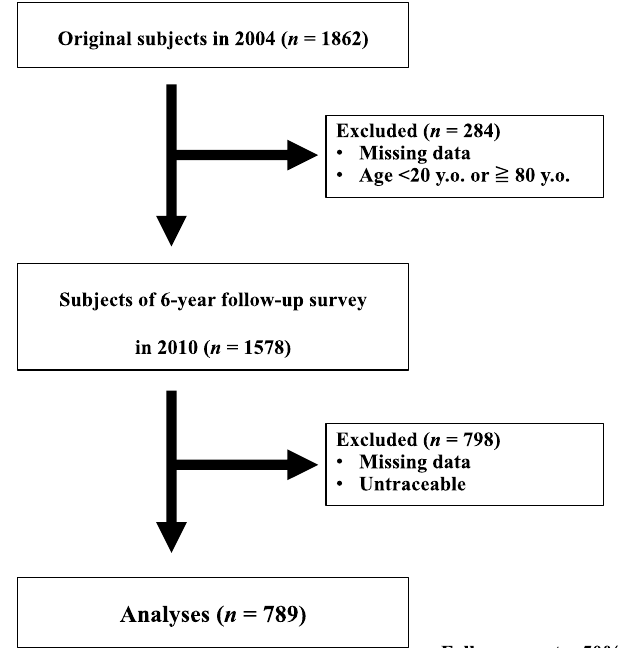
Figure 1. Figure 1. Participants.